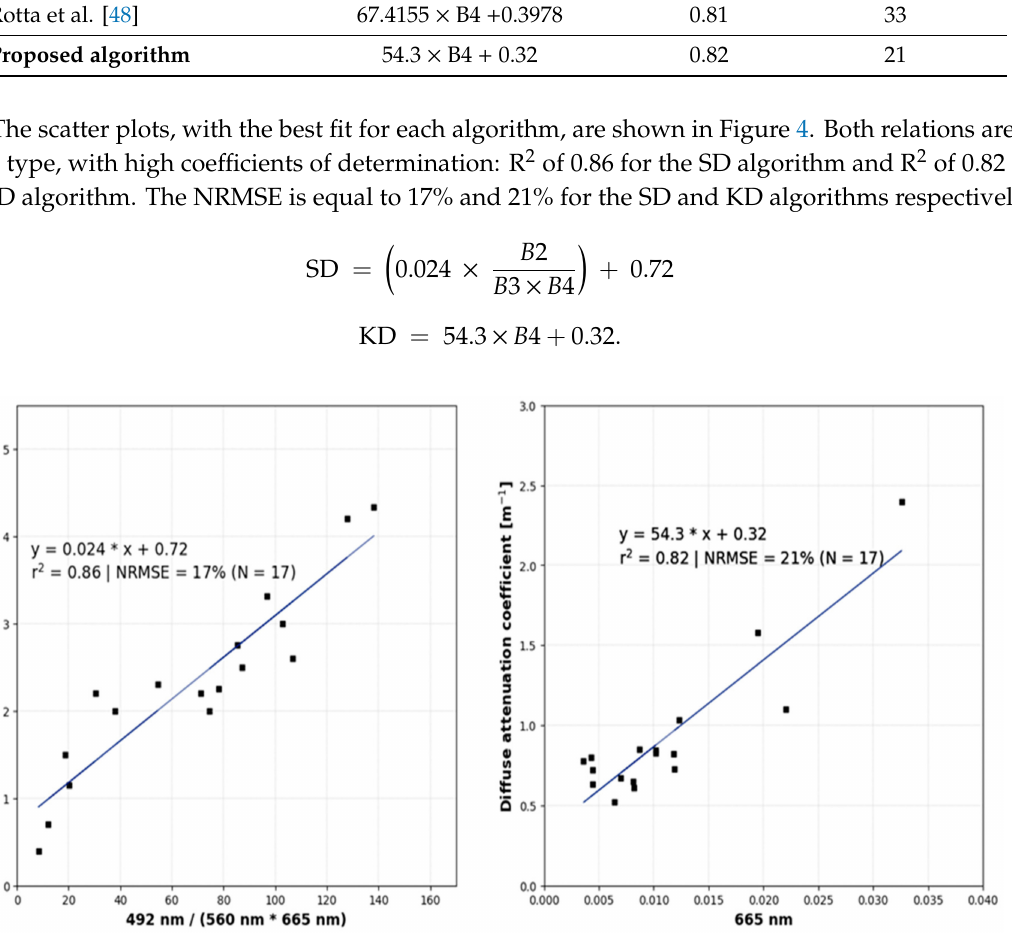
Figure 4. Scatter plot between parameters of water quality (SD on the left and KD on the right) and the bands of MSI. Shown also is the linear regression